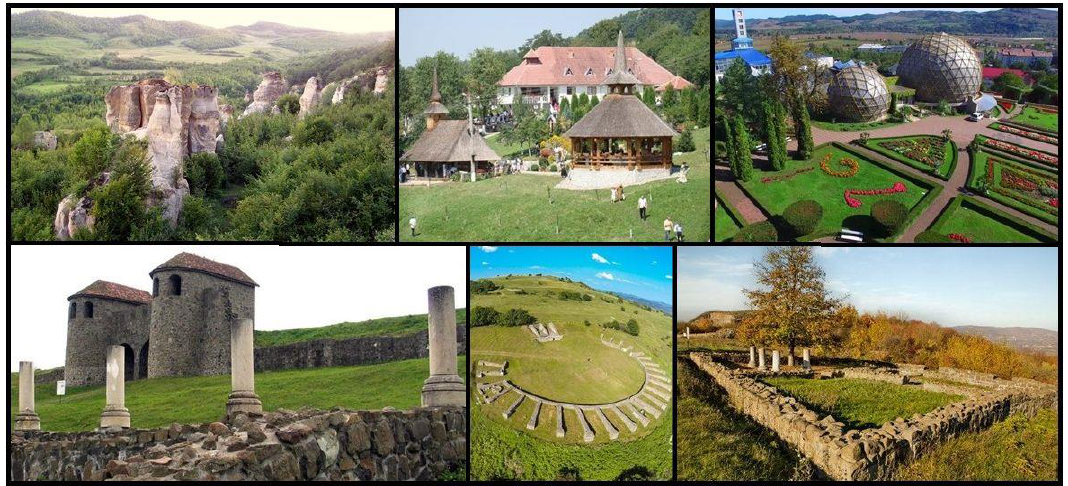
Figure 3. Local tourist attractions; Dragons’ Garden ( top left ), Strâmba Monastery ( top center ), Jibou Botanical Garden ( top right ), Roman city of Porolissum ( bottom ).